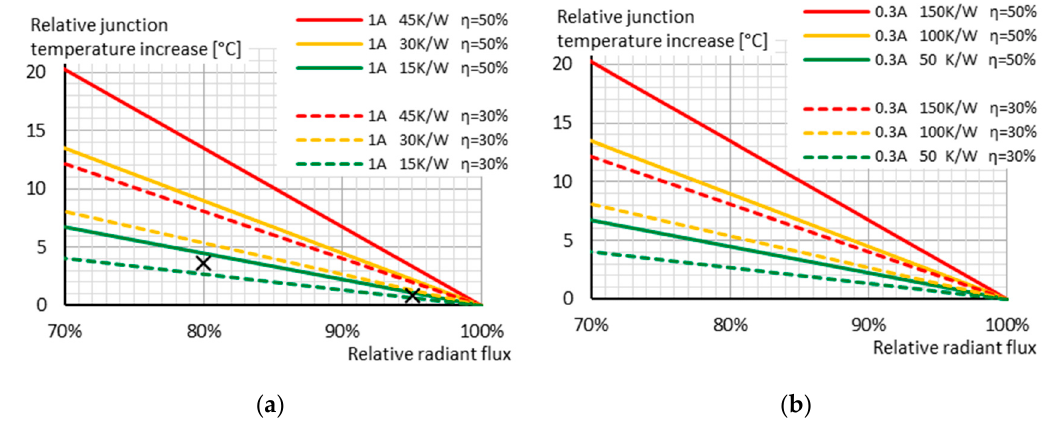
Figure 2. Theoretical pn-junction temperature increase during an LM-80 test in case of ( a ) a high-power and ( b ) a mid-power LED, as the function of the forward current, the thermal resistance, the zero-hour radiant efficiency and the reached luminous flux decay (assuming a constant thermal resistance and a Figure 3. V forward voltage). Note that the curves on ( a ) and ( b ) are identical implying that the junction temperature increase may affect high- and mid-power LEDs equally, depending on the thermal resistance.